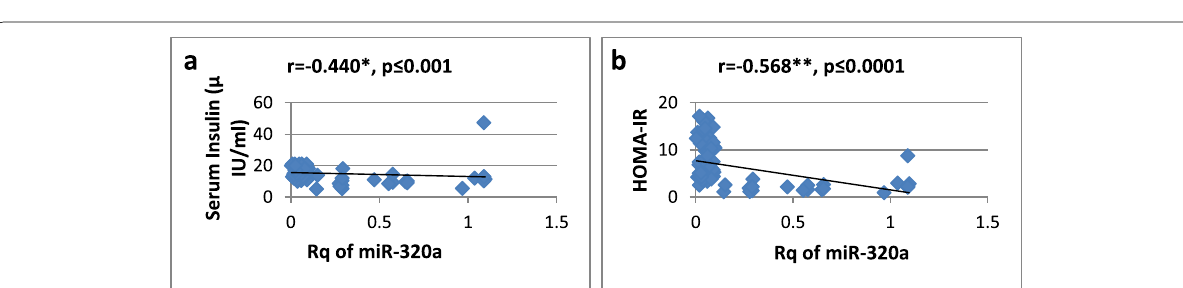
Fig. 8 a , b Correlation coefficient between Rq of MicroRNA 320‑a and both WHR ( r ( r 0.620), where “**” means significant at p = −